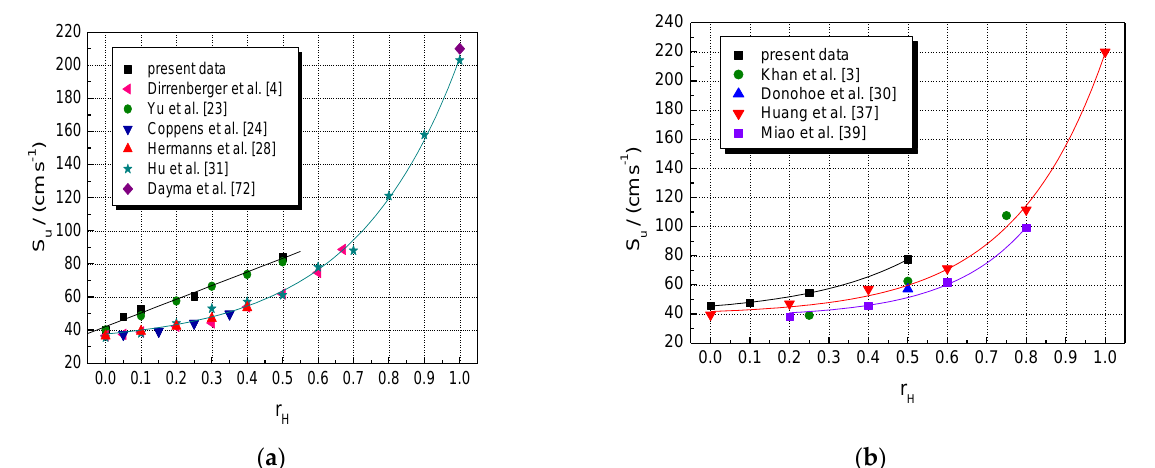
Figure 2. Laminar burning velocities of single fuel–air and multifuel–air mixtures with various r H at ambient initial pressure and temperature: ( a ) CH 4 –H 2 –air; ( b ) NG–H 2 –air mixtures (present experimental data, in comparison with literature values).